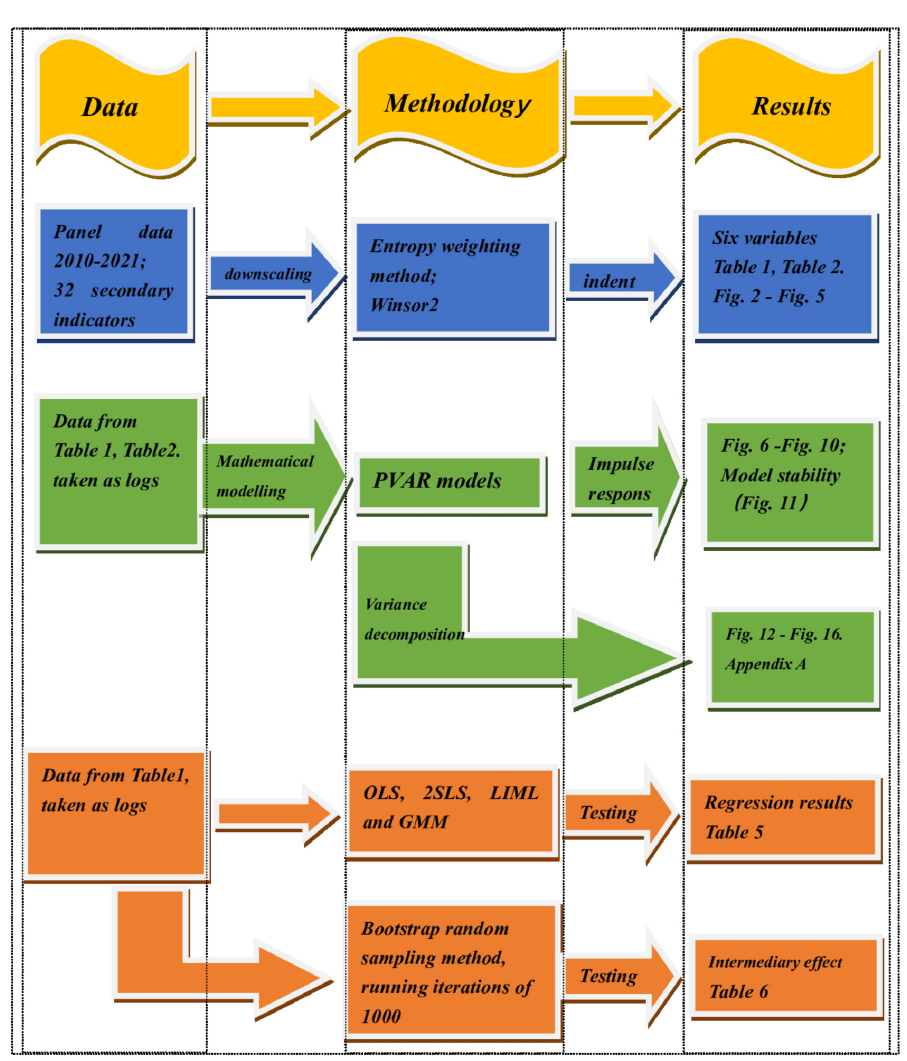
Figure 1. Methodology flowchart. From the left, the first column shows the data used, the second column shows the method used, and the third column shows the conclusions drawn or the results of the model